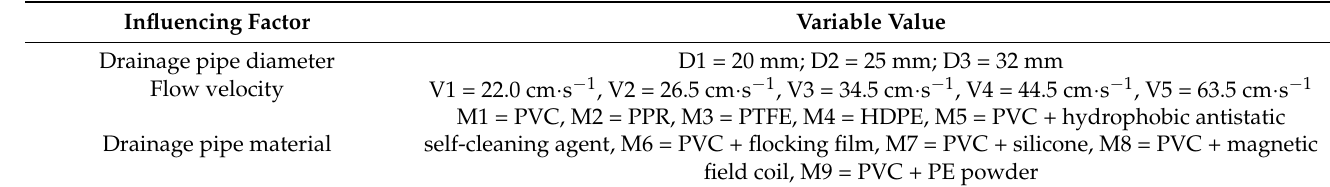
Figure 3. Test device diagram. ( a ) Elevation. ( b ) Top view.